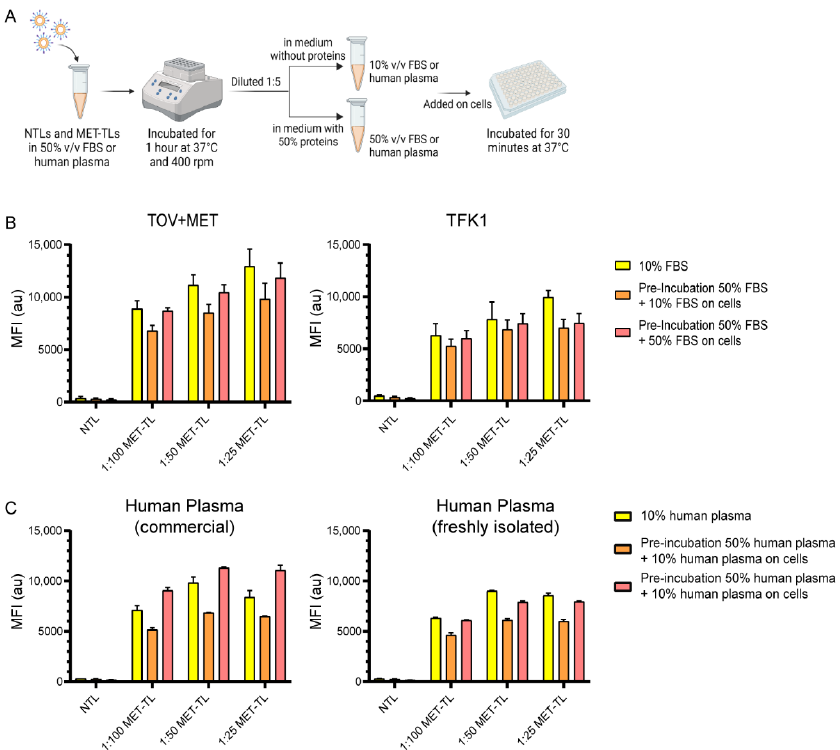
Figure 5. Effect of protein concentration on the targeting efficiency of MET-targeted liposomes (MET-TLs). ( A ) Schematic overview of the methodology employed to study the effect of pre-incubation on the MET-TLs with 50% FBS or 50% v / v human plasma on MET-TL-cell association. ( B ) Association of non-targeted liposomes (NTLs) and MET-TLs pre-incubated with 50% FBS with TOV+MET and TFK1 (+MET) cells. ( C ) Association of NTLs and MET-TLs pre-incubated with 50% human plasma with TFK1 cells. ( B , C ) Cells were incubated with dispersions of 60 µM of fluorescently labeled liposomes for 30 min under standard culture conditions. Liposome association was measured with flow cytometry and plotted as mean fluorescent intensity (MFI). Data were normalized to the control group (non-treated cells) mean and expressed as mean ± SD of two independent experiments (performed in duplicate). In a previous study, it was reported that the in vitro uptake of NPs was dependent on the source of medium supplementation [54]. Therefore, the association of MET-TLs was also studied in media supplemented with human plasma (either commercial or freshly isolated from the blood). As depicted in Figure 5C, the mean fluorescence intensity was not affected compared to the observed signal when TFK1 cells were incubated with MET-TLs and dispersed in FBS at the same protein concentration (Figure 5B), which indicates that human plasma does not further reduce receptor binding. As observed for the FBS-exposed samples, the association of MET-TLs was also reduced when the formulations were pre-incubated with 50% human plasma. Importantly, targeted liposomes still exhibited approximately a 20-fold higher association with TFK1 cells than NTLs. Interestingly, there was an increase from approximately 12% to 30% in the uptake when the cells were kept in 50% commercial human plasma during incubation with MET- TLs, while for the freshly isolated human plasma this was not verified. The impact of the protein corona on targeting efficiency has been previously investigated for different targeting moieties. Similarly to our data, mAb-targeted liposomes and micelles retained their advantage over their non-targeted counterpart after